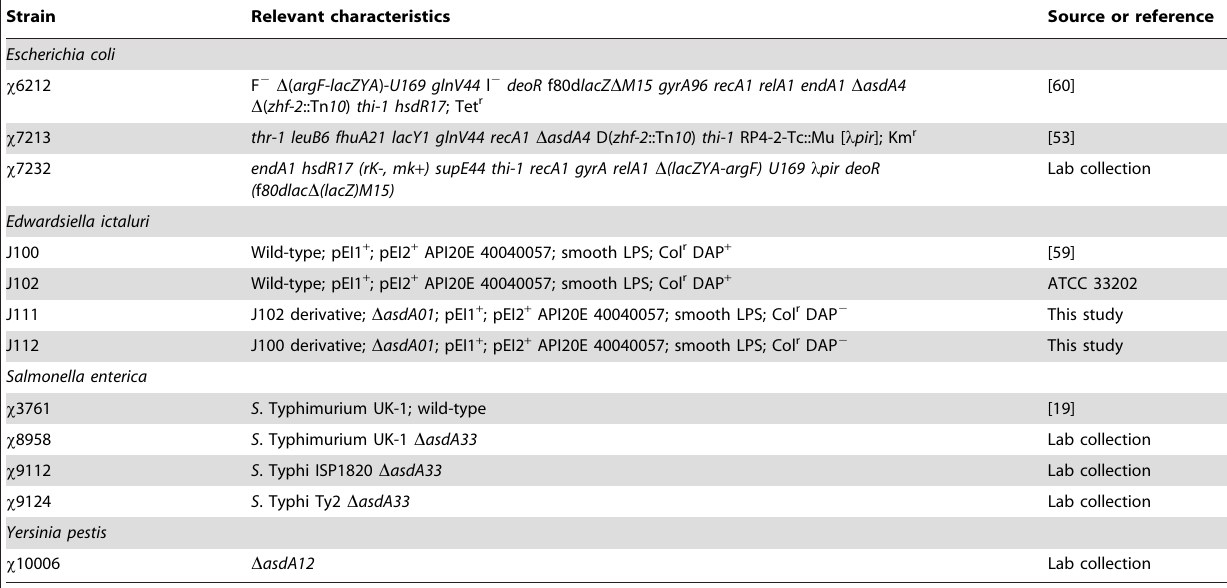
Strain Relevant characteristics Source or reference